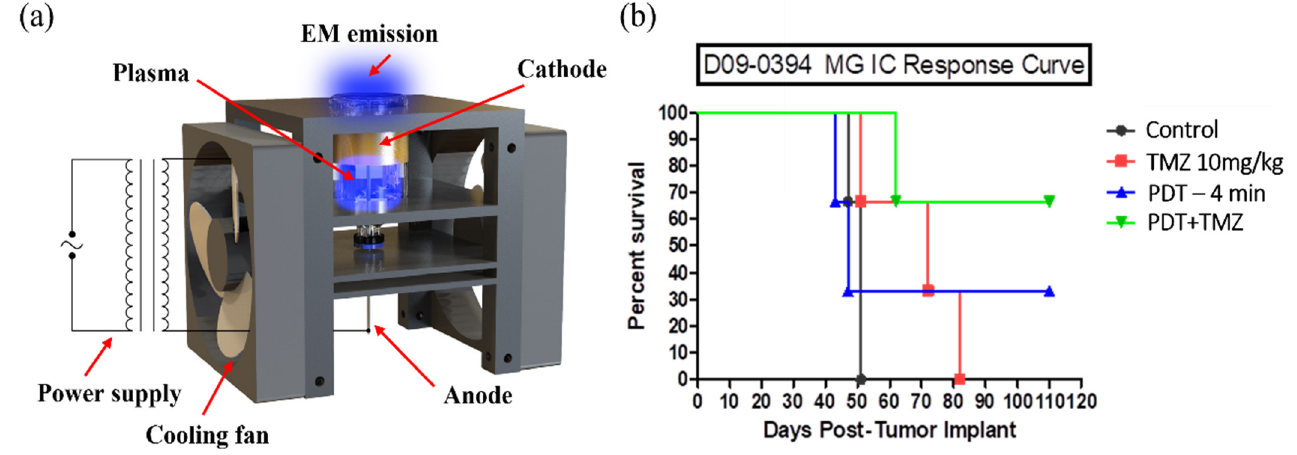
Figure 6. Sensitization of brain cancer cells to temozolomide (TMZ) by a cold plasma discharge tube (PDT). ( a ) Basic structure of PDT source. ( b ) Mouse survival rate curve. Reprinted with permission from Ref. [96]. 2022, American Chemical Society.